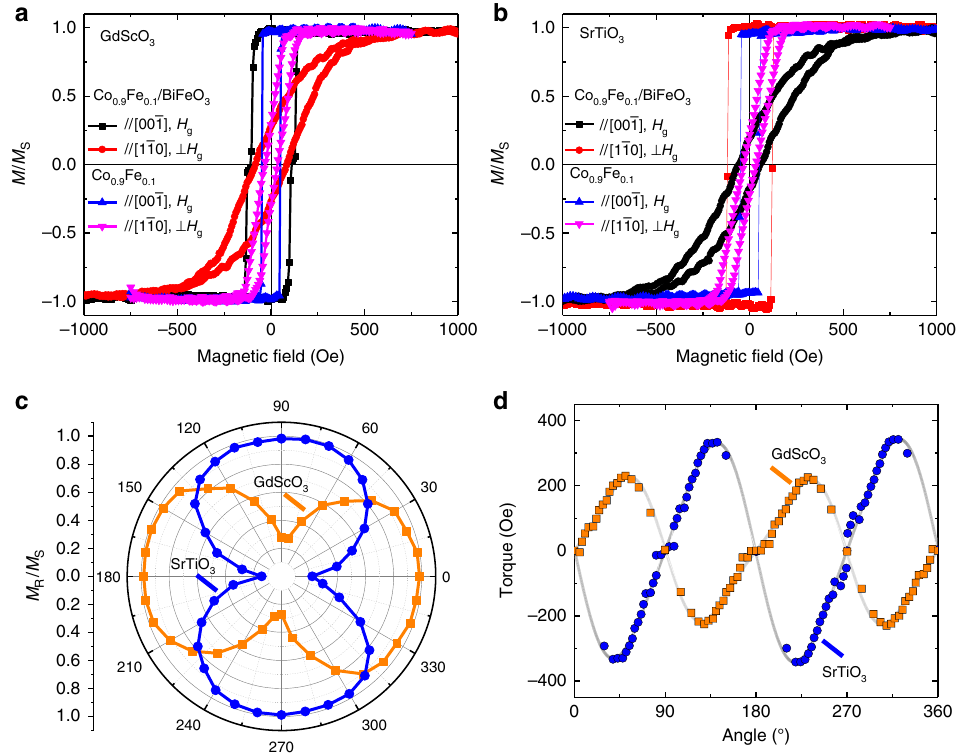
Fig. 5 Controlling ferromagnetic anisotropy. a Room temperature magneto-optical Kerr effect (MOKE) hysteresis loops measured in-the-plane of the fi lm for the Pt/Co 0.9 Fe 0.1 /BiFeO 3 /GdScO 3 (010) O heterostructures with H g along [001] and similarly grown Pt/Co 0.9 Fe 0.1 /GdScO 3 (010) O heterostructures. b Room temperature MOKE hysteresis loops measured in-the-plane of the fi lm for the Pt/Co 0.9 Fe 0.1 /BiFeO 3 /SrTiO 3 (110) heterostructures with H g along [001] and similarly grown Pt/Co 0.9 Fe 0.1 /SrTiO 3 (110) heterostructures. c Polar plot of the evolution of M R / M S for the Pt/Co 0.9 Fe 0.1 /BiFeO 3 /GdScO 3 (010) O and SrTiO 3 (110) heterostructures. The angle is de fi ned between the applied fi eld H and the [001]. d Magnetic torque as a function of angle of M R / M S for the two